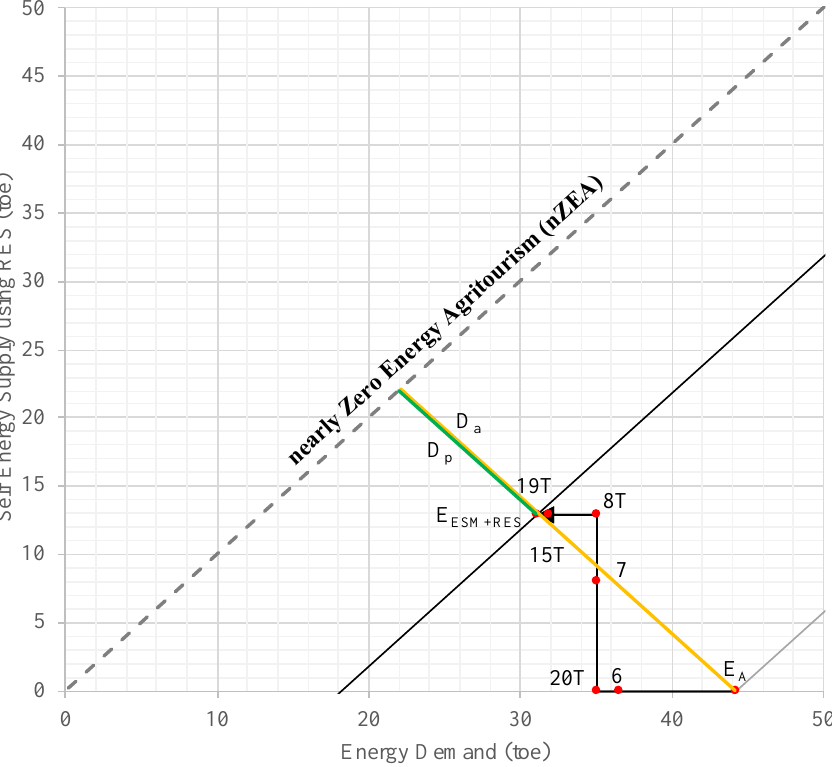
Figure 4. Path towards a nearly zero energy condition (nZEA) for Villa Dafne .